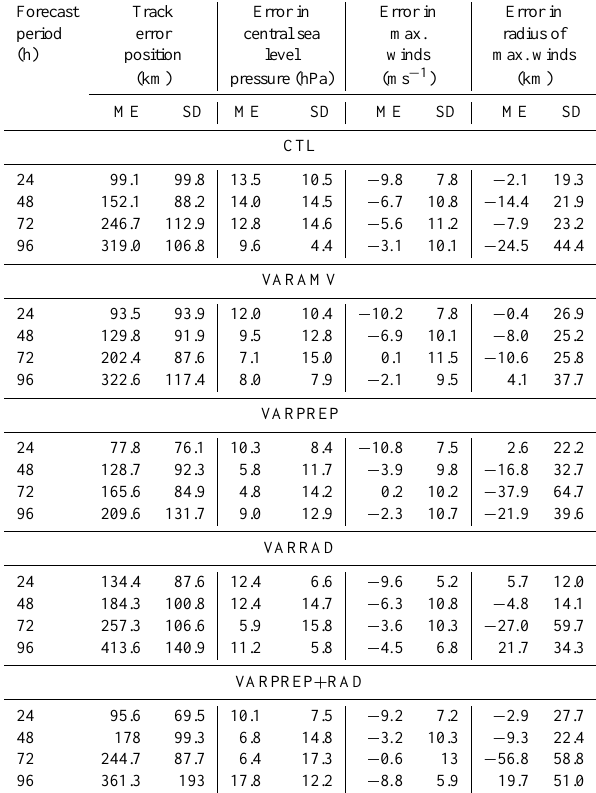
Table 2. Mean error (ME) and standard deviation (SD) in vec- tor track position, CSLP, MSW and the radius of maximum winds (RMW) in different experiments for all eight selected tropical cy- clones. Forecast Track Error in Error in Error in period error central sea max. radius of (h) position level winds max. winds (km) pressure